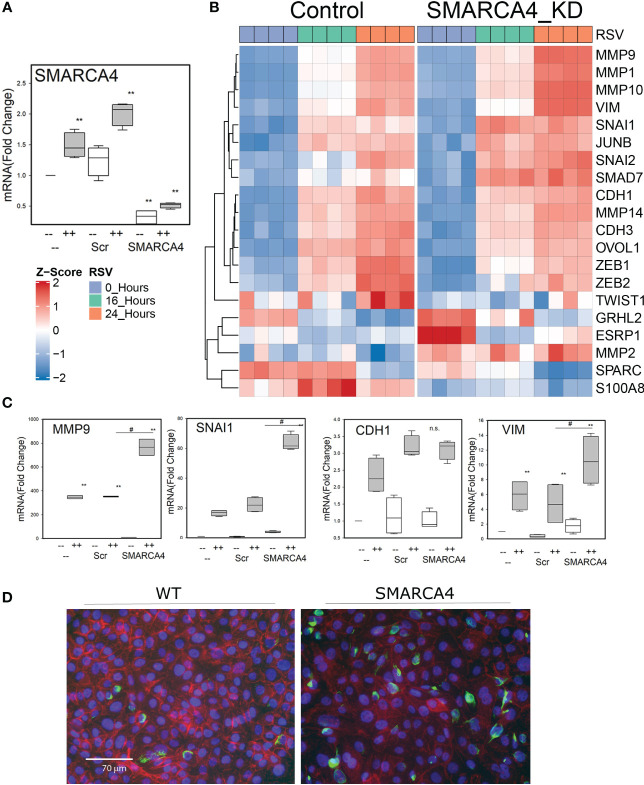
Effect of the SMARCA4 complex depletion on the EMT program. (A) Q-RT-PCR for SMARCA4 knockdown. RNA was prepared from uninfected or 24 h infected scrambled or SMARCA4 knockdown cells. Data is normalized to internal control PP1A and expressed as fold change relative to uninfected WT cells. *p <0.01, ANOVA, with contrast using post-hoc Tukeys. (B) Hierarchical clustering of EMT signature genes. Expression patterns of signature epithelial or mesenchymal genes in the time course were z-score–normalized and subjected to hierarchical clustering using Euclidian distance. Abbreviations used are: MMP, matrix metalloproteinase; SNAI1, Snail Family Transcriptional Repressor 1; JunB, JunB Proto-Oncogene; CDH, Cadherin; VIM, vimentin; SPARC, Secreted Protein Acidic And Cysteine Rich; ITGB3, integrin Subunit Beta 3; TWIST, Twist Family BHLH Transcription Factor; S100A8, S100 Calcium Binding Protein A8; ZEB: Zinc finger E-box binding homeobox. (C) Q-RT-PCR for EMT pathway “signature genes”- MMP9, VIM, SNAI1, CDH2, and CDH1. RNA was prepared from uninfected or 24 h infected cells (MOI 1). Data is normalized to internal control PP1A and expressed as fold change relative to uninfected WT cells. **p <0.01, ANOVA, with contrast using post-hoc Tukeys. #p<0.01 compared to Scr. (D) Immunofluorescent staining of SMARCA4-depleted cells. Cells were stained with VIM (green) and CDH1 (red). Note the loss of cell surface CDH1 and the accumulation of VIM in the SMARCA4 complex-depleted cells, characteristic of pEMT.